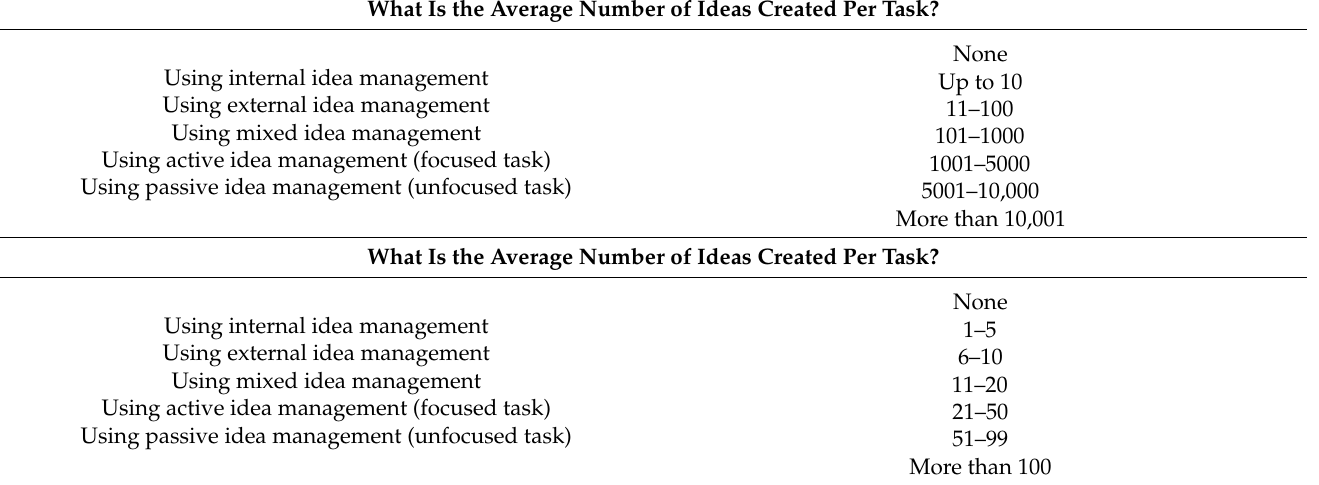
Table 2. Survey questions about quantity and quality. What Is the Average Number of Ideas Created Per